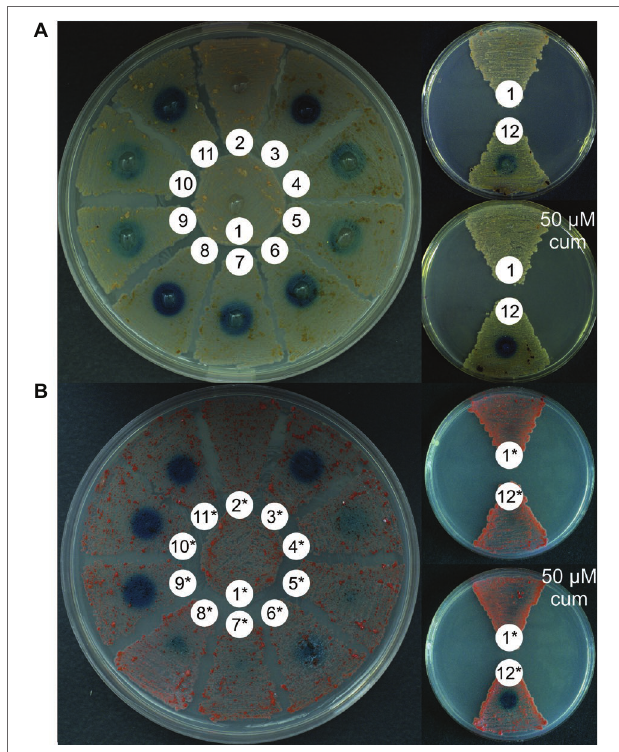
FIGURE 1 | Comparison of GusA activity in recombinant strains of N. gerenzanensis (A) and N. coxensis (B) , carrying the following promoter-probe vectors: 2, 2* – pTEGA ( gusA under the control of ermEp ); 3, 3* – pSAGA ( gusA under the control of aac(3)IVp ); 4, 4* – pHBP ( gusA under the control of hrdB ng p ); 5, 5* – pRBP2 ( gusA under the control of rpoB Rng p ); 6, 6* – pRBP1 ( gusA under the control of rpoB ng p ); 7, 7* – pSBP ( gusA under the control of ssb ng p ); 8, 8* – pRLP ( gusA under the control of rpsL ng p ); 9, 9* – pGUSmoeE5script ( gusA under the control of moeE5p ); 10, 10* – pGT2p ( gusA under the control of tei2p ); 11, 11* – pGBP ( gusA under the control of gyrB ng p ); 12, 12* – pGCymRP21 ( gusA under the control of P21-cmt ). The control parental strains (1, N. gerenzanensis and 1*, N. coxensis ) do not display chromogenic conversion of X-Gluc. Strains were cultivated for 6 days on VM0.1